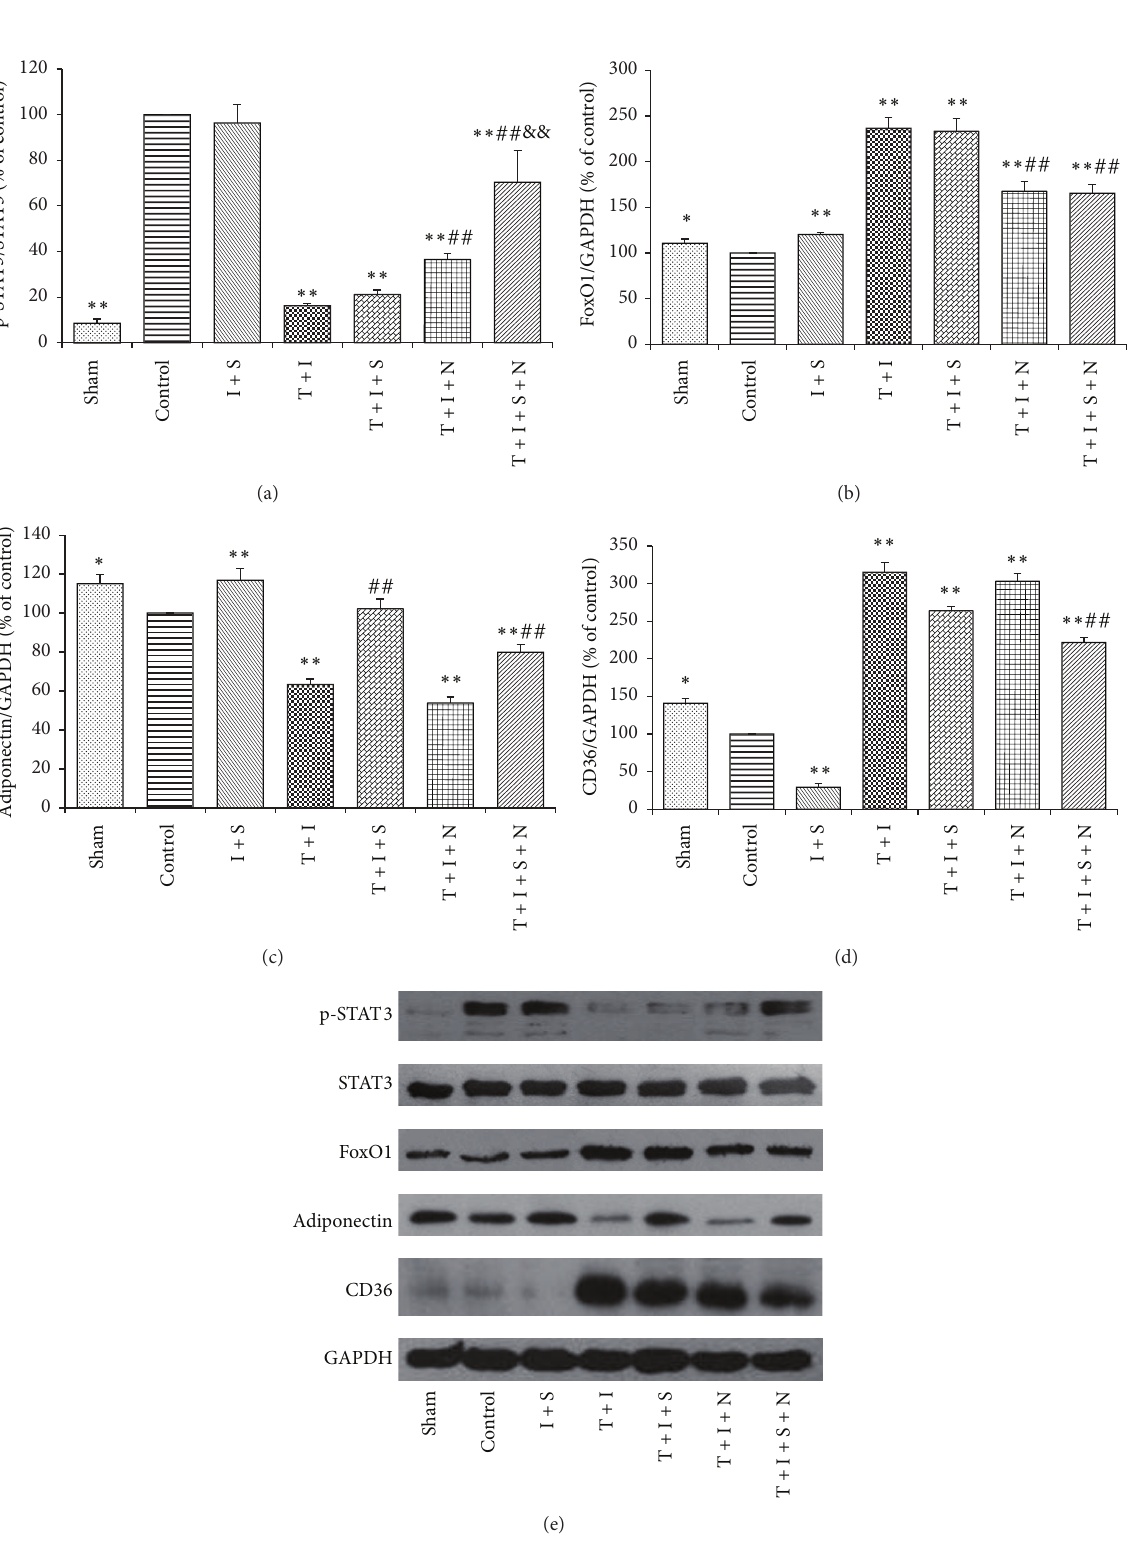
Figure 3: Expression of myocardial p-STAT3 (a), FoxO1 (b), adiponectin (c), CD36 (d), and pictorial diagram of western blots (e) after myocardial IR. Heart tissues were stored at − 80 ∘ C right after reperfusion. Data was expressed as mean ± SEM ( 𝑛 = 6 per group). I, T, S, and N, respectively, stand for ischemia-reperfusion (I), Type 1 diabetes (T), sevoflurane (S), and N-Acetylcysteine (N); control: ischemia- reperfusion untreated group. ∗ 𝑃 < 0.05 ; ∗∗ 𝑃 < 0.01 compared with control group; ## 𝑃 < 0.01 compared with T + I group. && 𝑃 < 0.01 compared with T + I + N